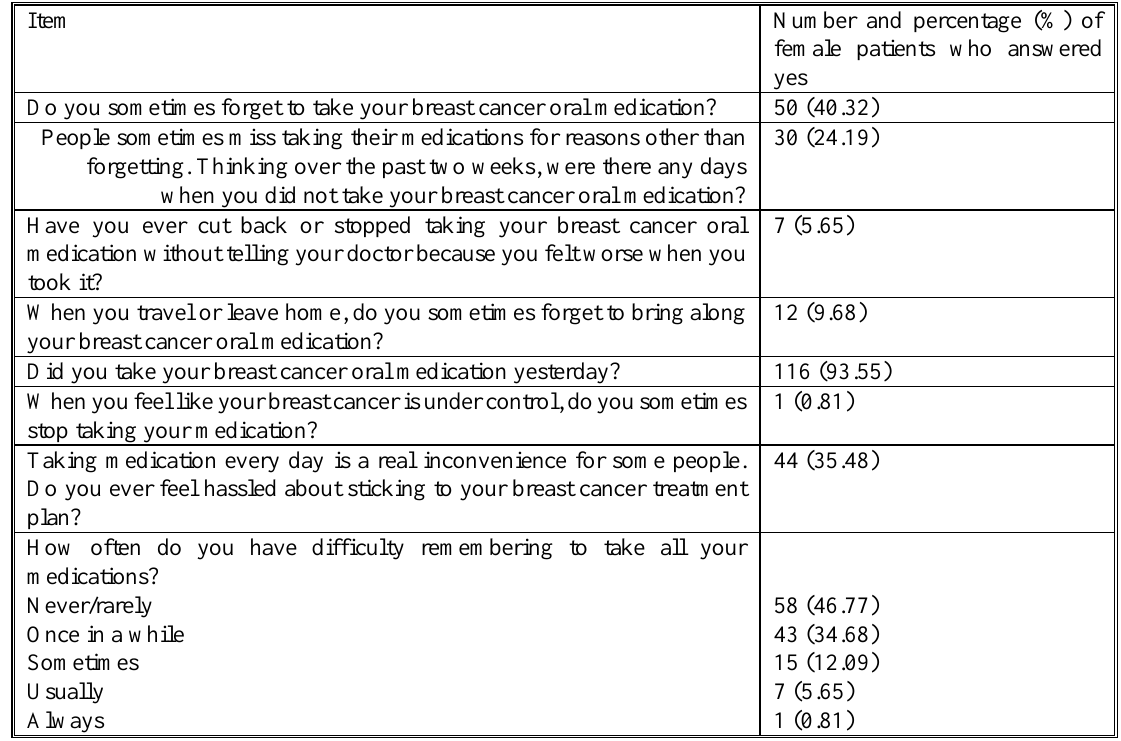
Table 2. Self-reported medication adherence behavior of study participants as determined by the MMAS- 8 .